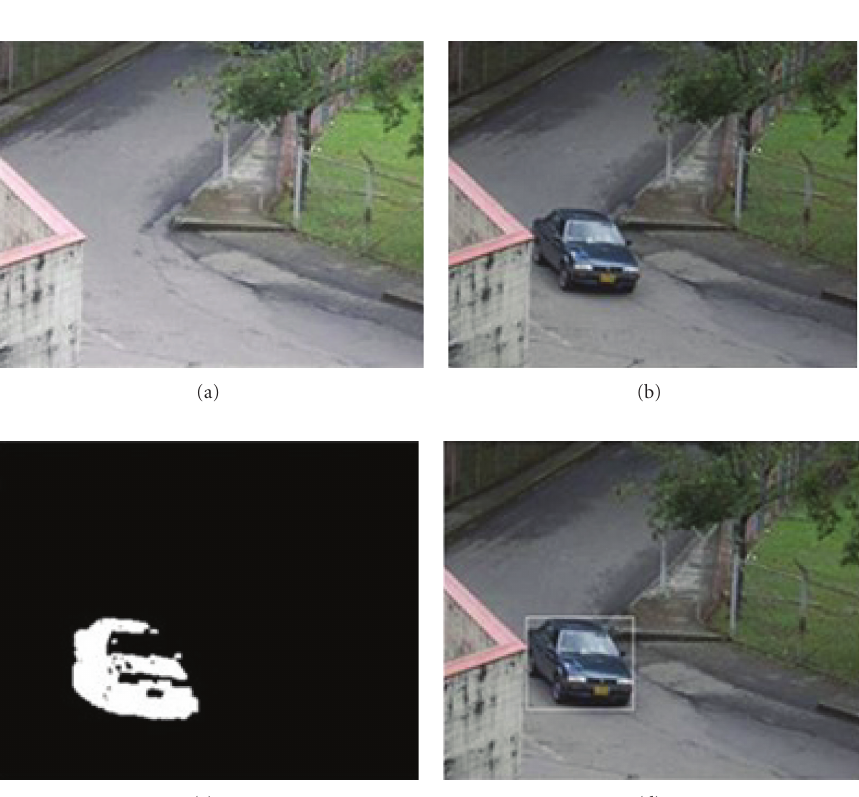
Figure 2: Image chain of the background subtraction algorithm: (a) background image; (b) new image; (c) image subtraction; (d) overlap of new image and object’s